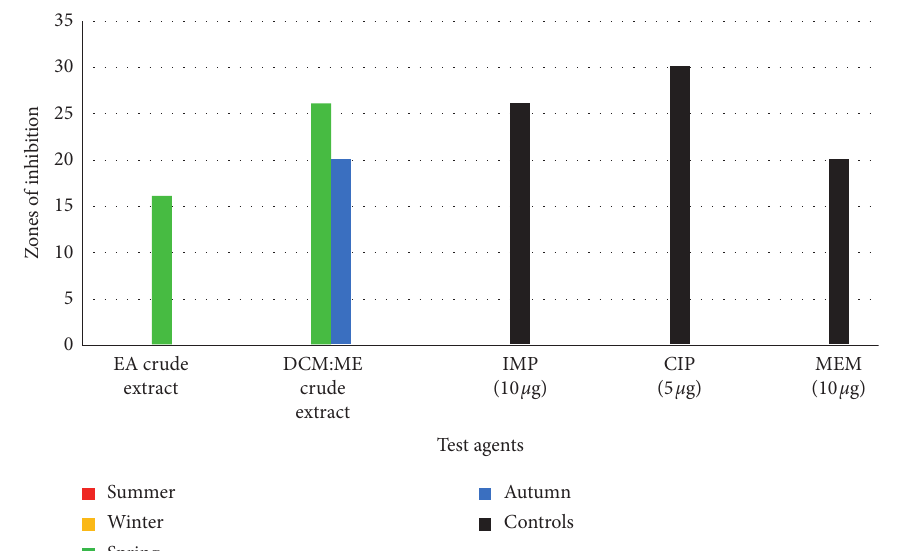
Figure 3: Antimicrobial activity of ethyl acetate (EA) and dichloromethane :methanol (DCM: ME) crude extracts against P. aeruginosa .